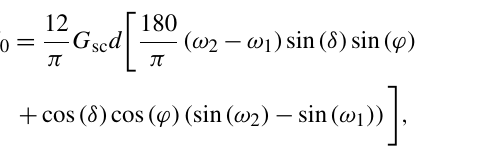
movement of the earth in orbit around the sun and around its axis of